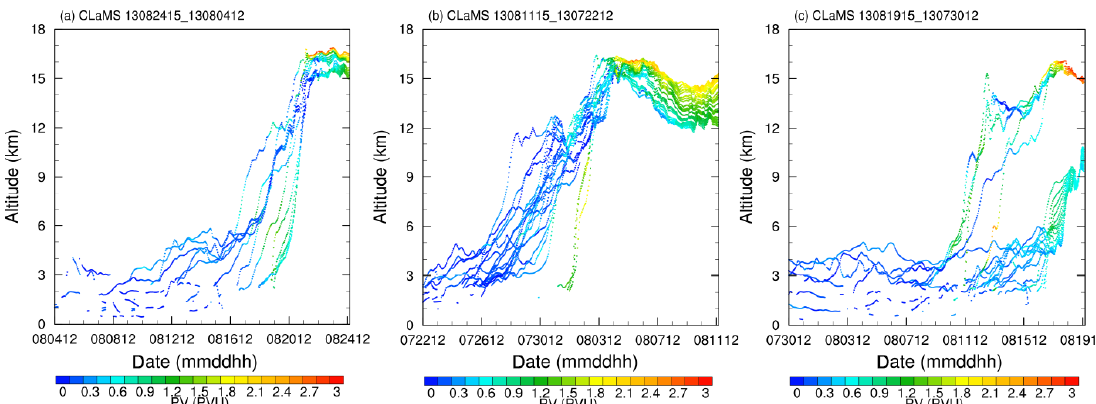
Figure 4. The same format as Fig. 3 (left), but potential vorticity (1PVU = 10 6 Km 2 kg − 1 s − 1 ) is shown along 20-day backward trajectories for observations impacted by (a) Trami, (b) Jebi, and (c)